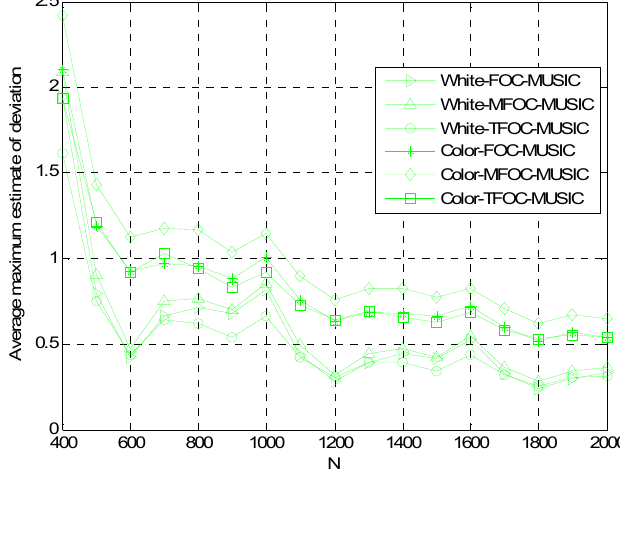
Figure 6. Average maximum estimate deviation comparisons versus snapshots L